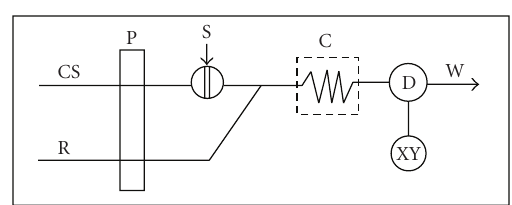
Figure 3: Schematic diagram of the FIA manifold used for the assay of promazine; R: iron(III) in hydrochloric acid solution; CS: water; P: peristaltic pump; S: samples injector; C: reactor; D: spectrophotometer adjusted to the corresponding wavelength of the oxidized form of phenothiazines; X: recorder; W: waste. of the proposed method has been the best at the molar ratio K 2 Cr 2 O 7 :PT equal to 1:6 at room temperature